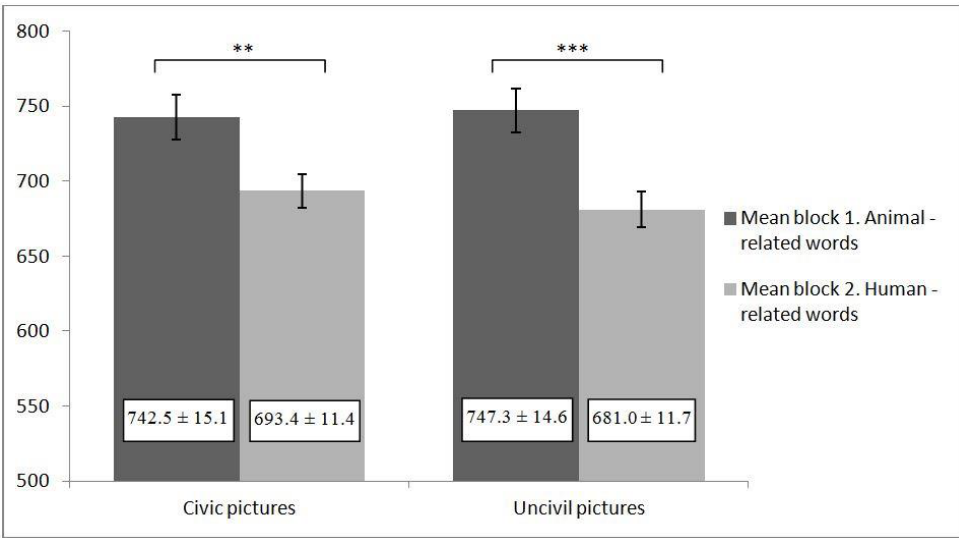
Figure 2. Means ± standard error for reaction times (in milliseconds) of block 1 and 2 in study 2. *** indicated p < 0.001, ** indicated p < 0.01.